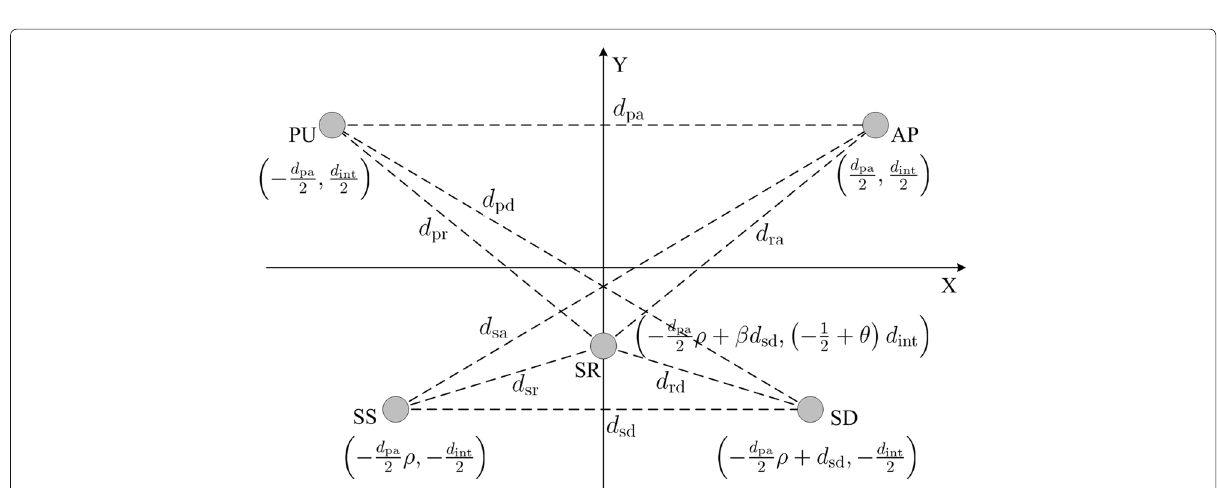
Fig. 3 Relative locations between the primary system and secondary